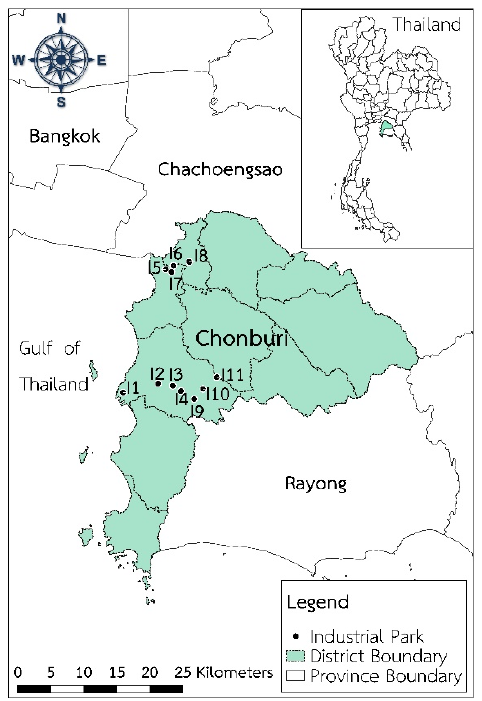
Figure 1. Locations of industrial parks in Chonburi Province, Thailand .